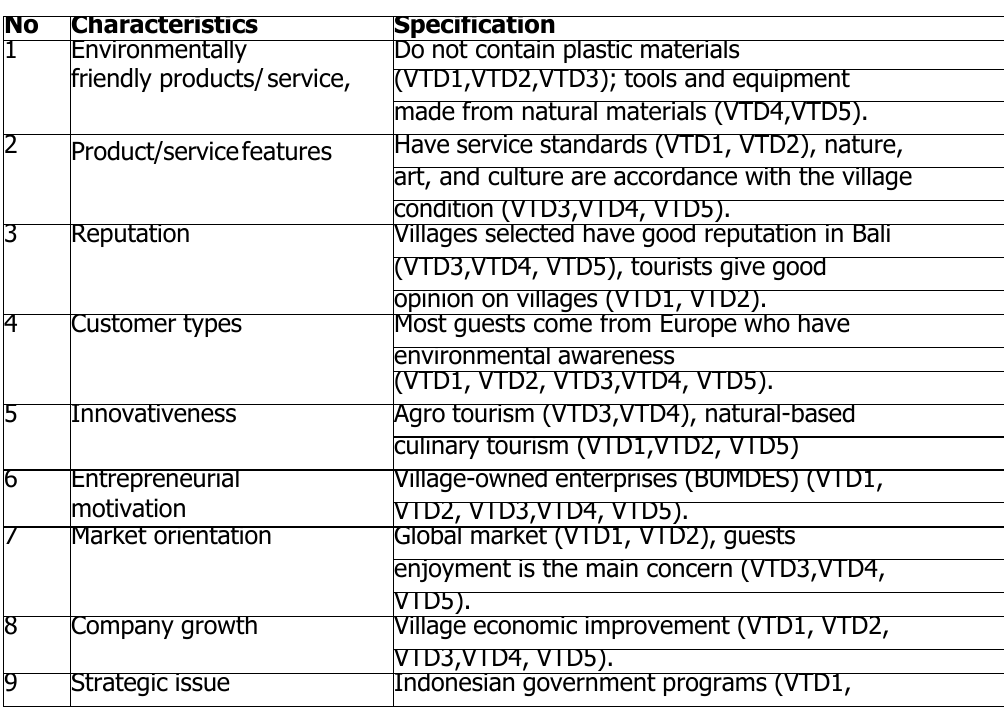
Table 1. Green Start-Up